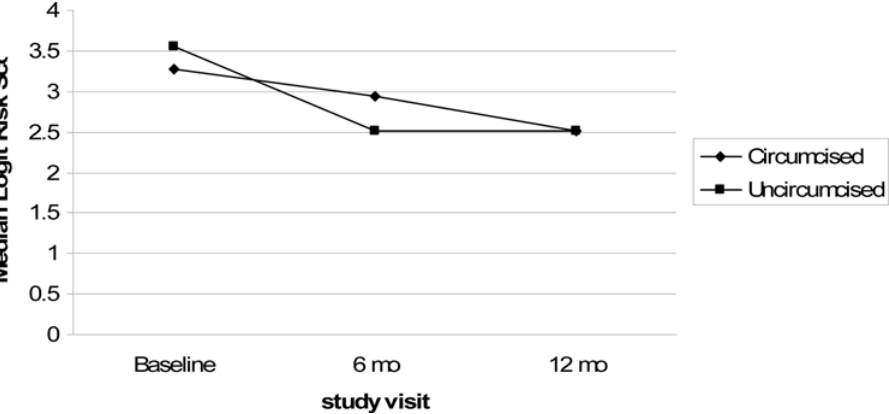
Figure 1. Median Risk Scores for Circumcised and Uncircumcised Men at Baseline, 6 and 12 month follow-up visits.